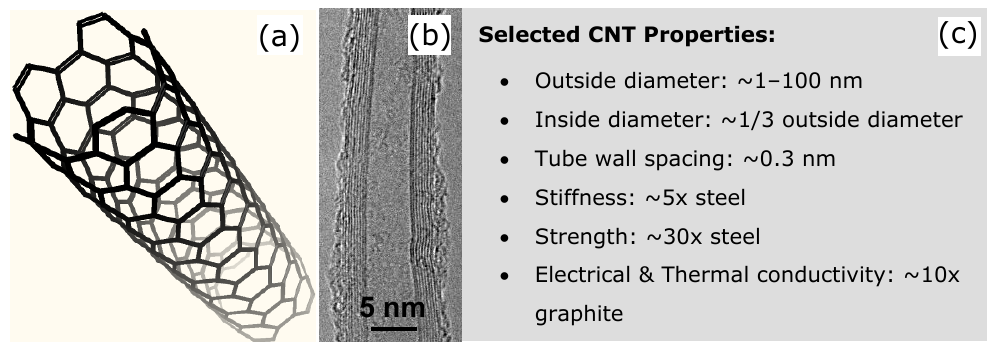
Figure 1. (a) Schematic of a CNT, (b) TEM image of a CNT showing a number of concentric graphitic walls, and (c) a list of selected CNT